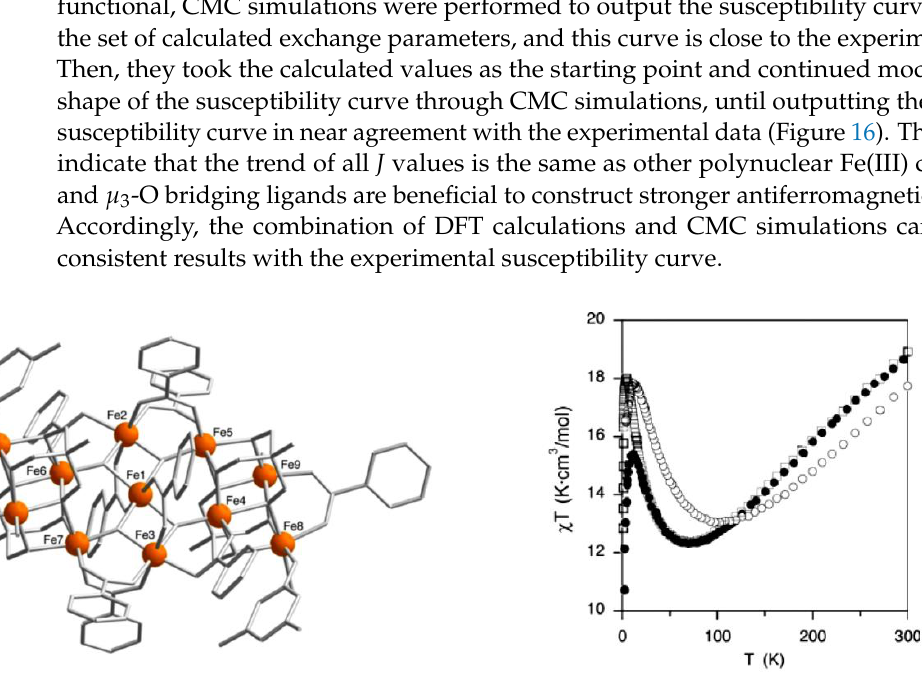
( b ) Figure 17. The coupling models of two high-nuclearity copper cage compounds: Cu 21 and Cu 16 . ( a ) Four J exchange pa- rameters were defined considering different bridging modes. ( b ) Two J exchange parameters were defined in view of the nearest Cu…Cu distances (adapted with permission from [68]). 4. Conclusions and Perspectives After years of effort, many excellent single-molecule magnets have been reported, which has depended on the joint efforts of synthetic chemists and theoretical researchers. Theoretical calculations can not only help us analyze and understand the experimental